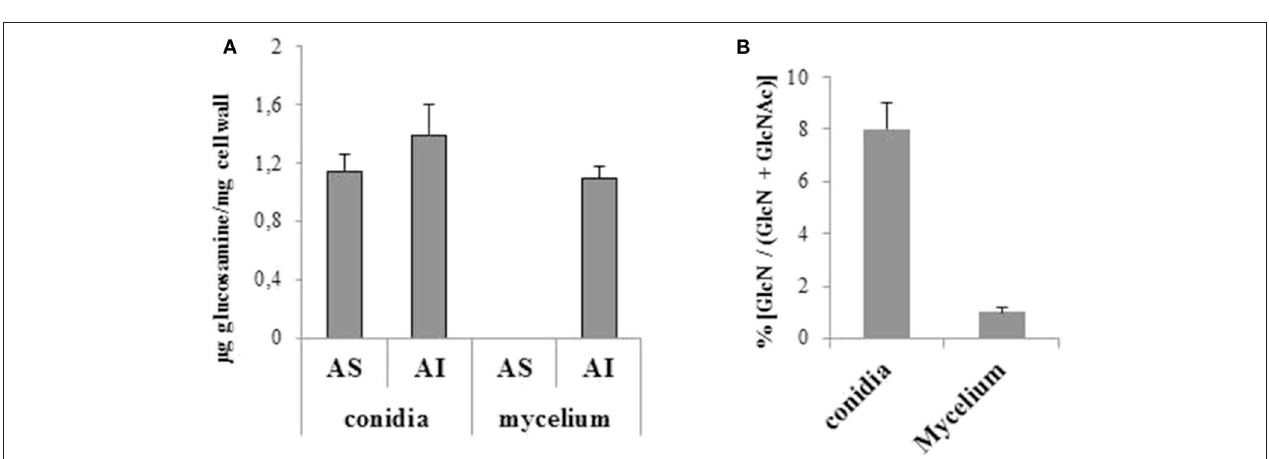
Frontiers in Cellular and Infection Microbiology |